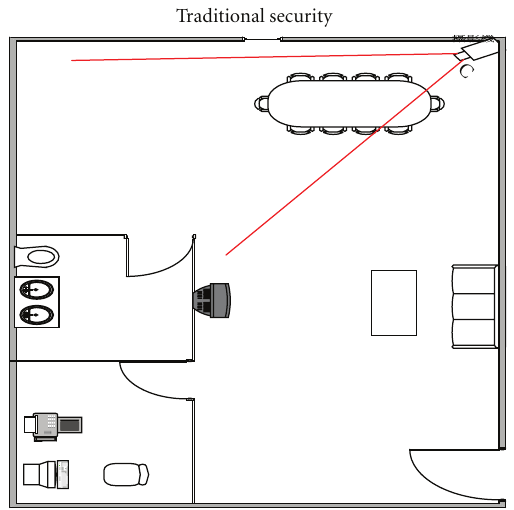
Figure 1: The traditional security system.